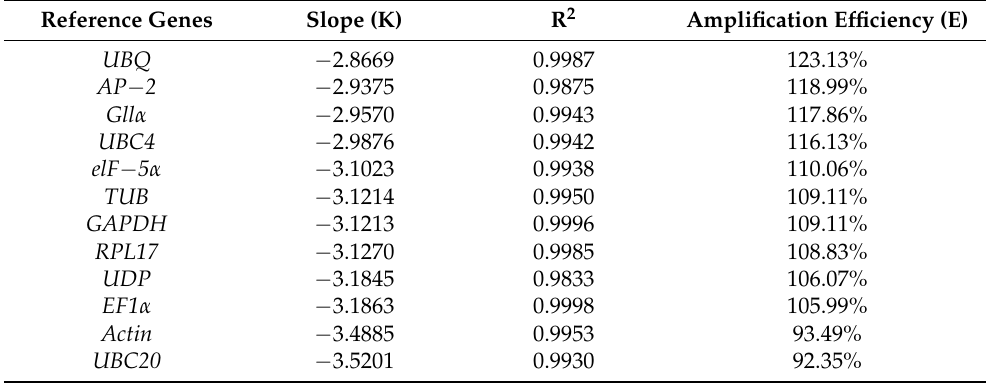
Table 1. Amplification efficiency and correlation coefficient of candidate reference